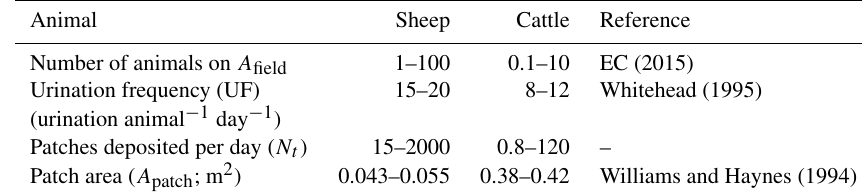
Table 1. Ranges of the parameters used in the calculation of the urine-covered proportion of a field with an area of 1ha ( = 10000m 2 ) .